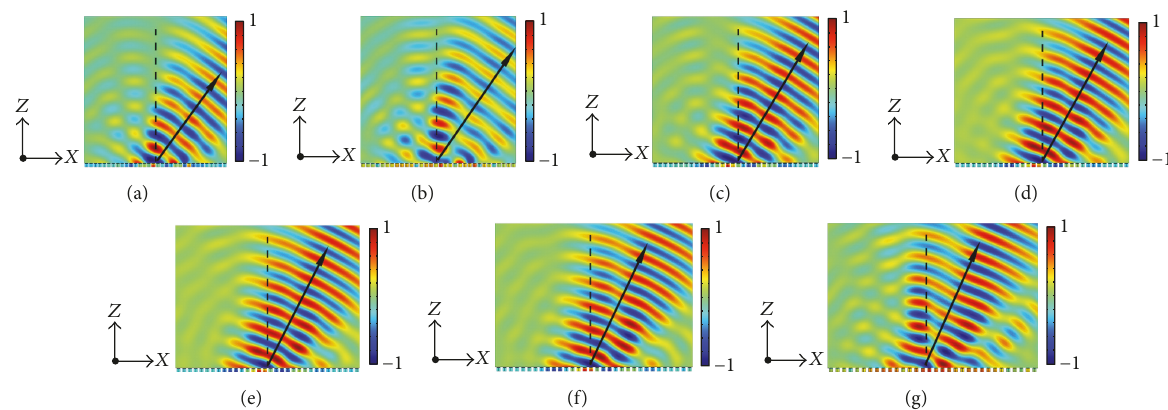
Figure3:Simulatedsnapshotsofpressuremapforthereflectedbeamsofthemetasurfaceswithsevendifferentunitspaces((a) ∼ (g)correspond to 120, 130, 140, 150, 160, 170, and 180 mm, respectively). The metasurfaces are located on the 𝑥 -axis. The incident waves with a Gaussian beam propagate along the negative direction of 𝑧 -axis. The amplitudes of the acoustic pressures are normalized. The reflected angle changes with the unit space.